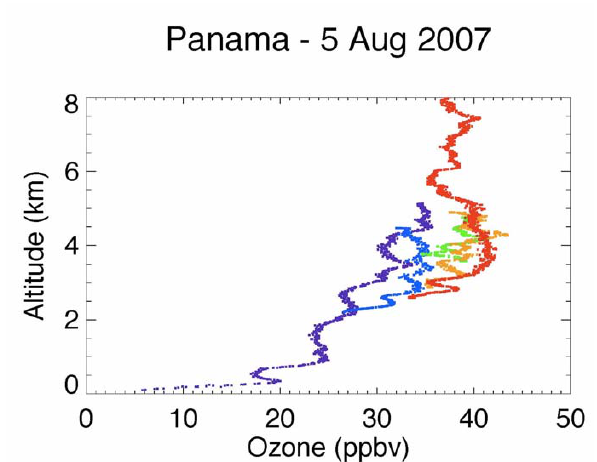
Fig. 5. Ozone vs. altitude on the ascents as the balloon oscillated on the 5 August 2007 flight, with color coding to match the ascents identified in Fig. 4.